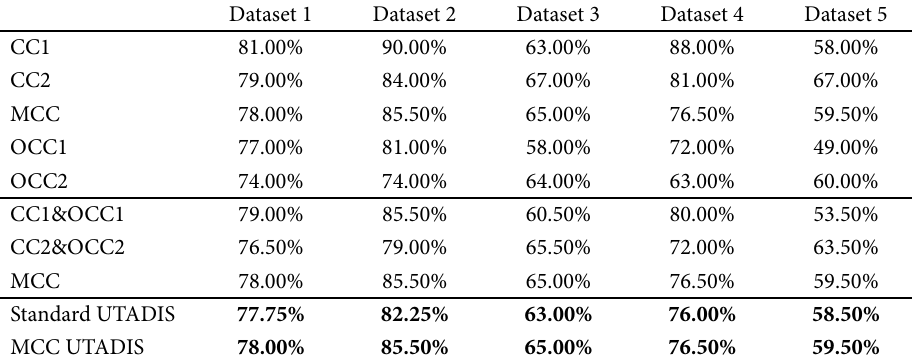
table 10. Overall prediction and explanation abilities of models for data